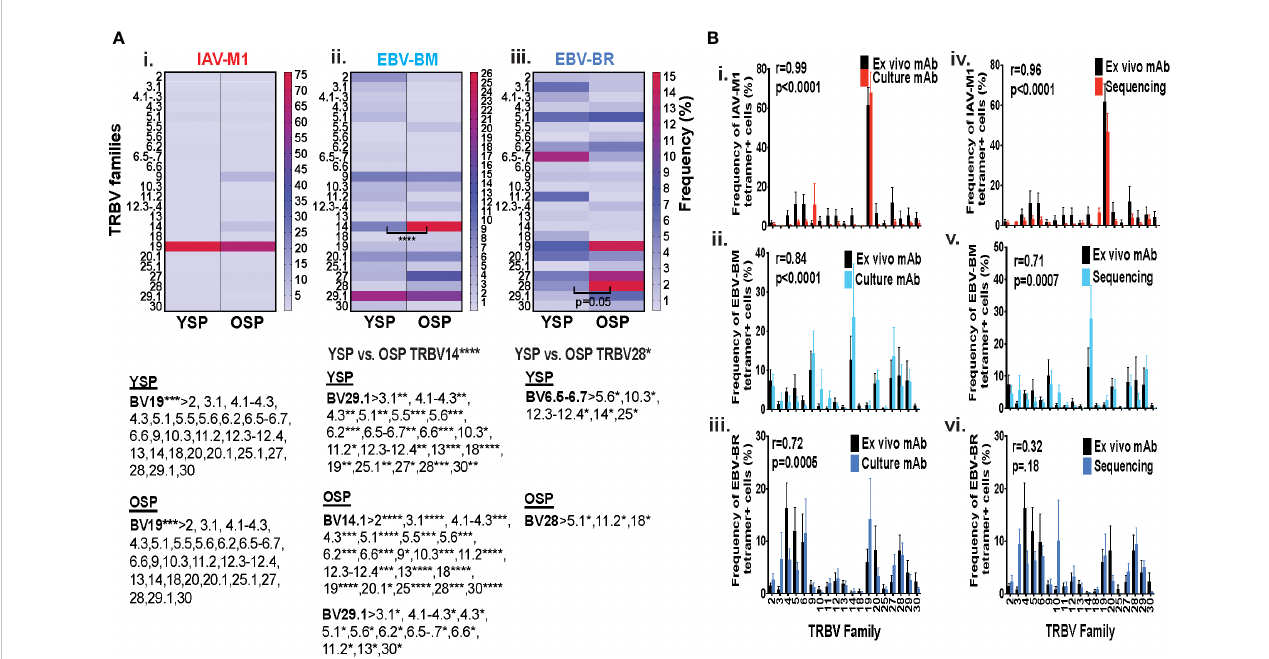
FIGURE 1 TRBV usage (A) as measured by mAb staining for EBV epitope-speci fi c responses differs between young (Y) and older (O) donors. Following short-term culture with either IAV-M1, EBV-BM or EBV-BR peptide, cognate (same speci fi city as the stimulating peptide) tetramer+ cells in each culture were stained with TRBV8 mAbs (Y n=12-13, O n=7-9). (A) Heatmap analysis shows that TRBV usage differed between Y and O donors in EBV-speci fi c responses either when frequency was directly compared between the groups or if the hierarchy of TRBV usage within the group was examined. A single TRBV family, BV19, dominated IAV-M1-speci fi c responses in both Y and O donors. The dominant BV usage for each speci fi city is shown below each heatmap. (B) Strong correlations in TRBV usage between short-term cultured and ex vivo antigen-speci fi c responses. TRBV repertoire as assessed by TRBV monoclonal antibody (mAbs) staining of ex vivo tetramer+ CD8 T cells were compared to those in short-term culture in the same donors as assessed by BV mAb staining (i-iii) or TCR high throughput sequencing (iv-vi) (Y n=4, O n=4-5). Multi-variant 2-way ANOVA with adjusted p-value, *p < 0.05, **p < 0.01, ***p < 0.001, ****p < 0.0001 (A, B) . Pearson ’ s correlation coef fi cient (r), r and p values indicated on